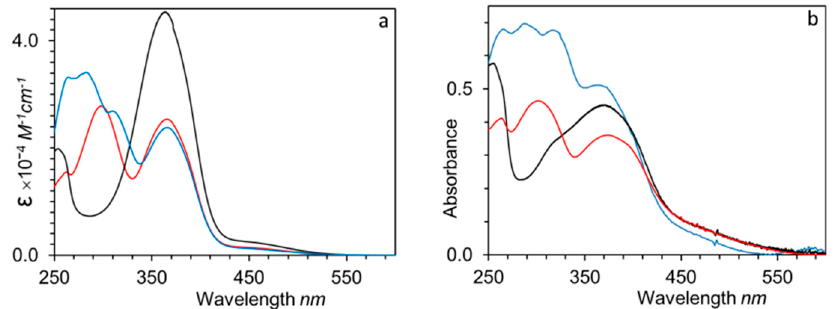
Figure 7. UV–Vis spectra in THF solution ( a ) and thin film ( b ) of P 100 (7eAZO / eAZO) (black lines), P 100 (10cCNB / eAZO) (red lines) and P 70 (7cCIN / eAZO) (blue lines).